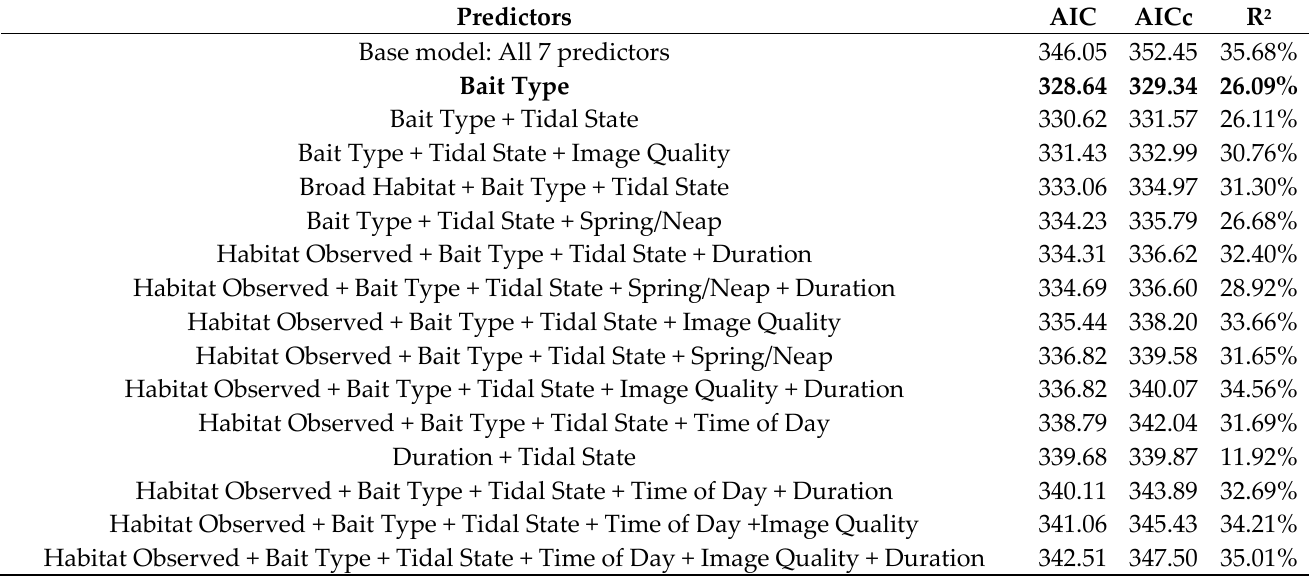
Table 2. Best-performing models assessing what predictors have the most influence over species richness during BRUV deployments based on AIC values. Note N/A has been excluded from this statistical